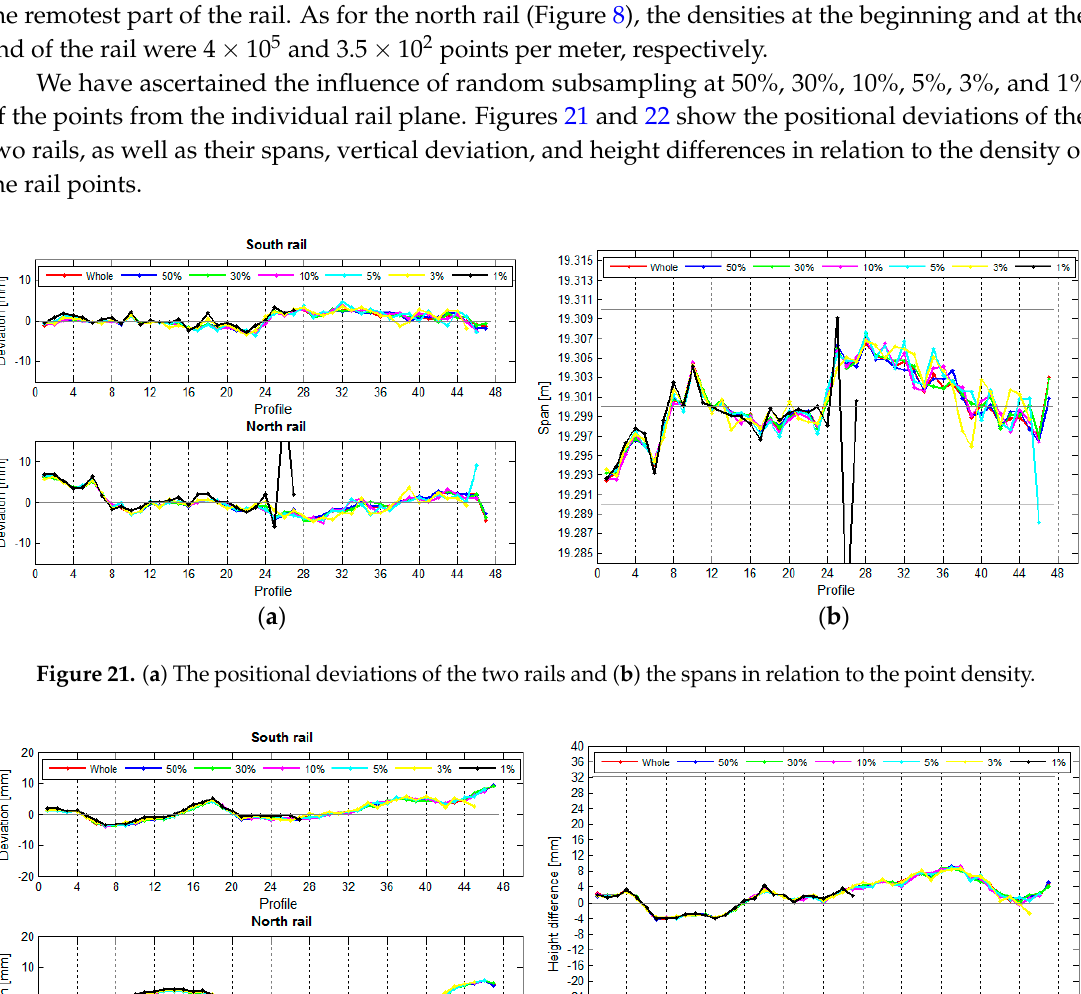
Table 4. Numeric representation of the deviation differences when removing points. Figure 22. ( a ) The vertical deviations and ( b ) the height differences in relation to point density.